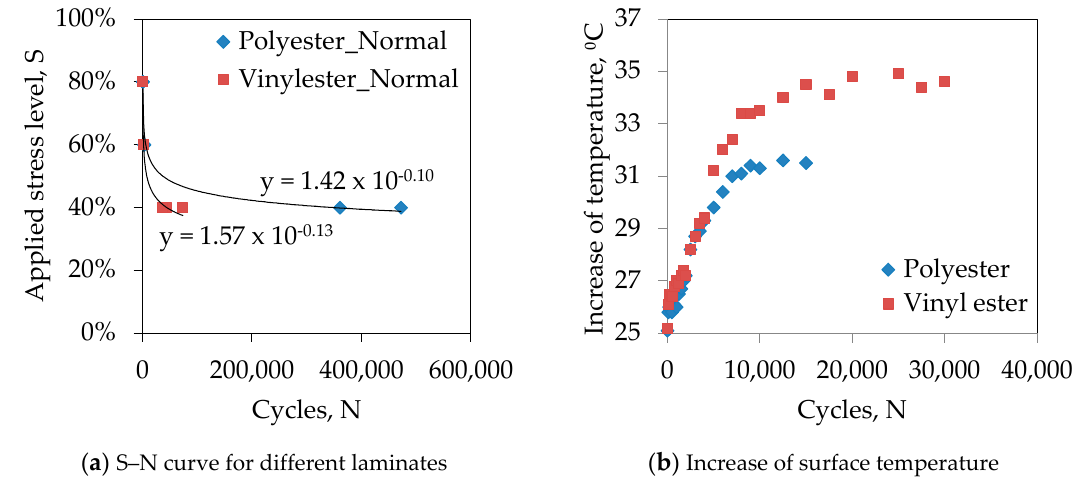
Figure 4. Comparison between polyester and vinyl ester based laminates.